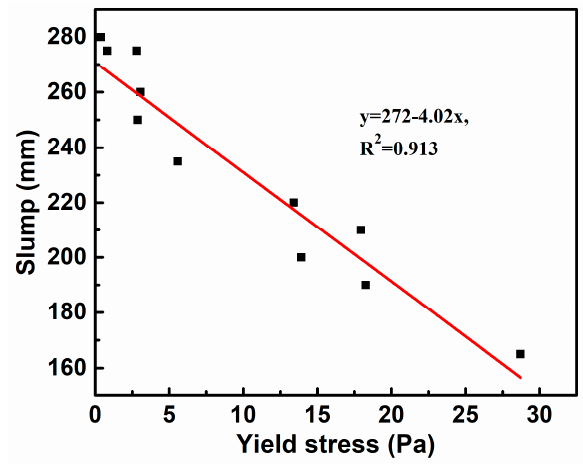
Figure 5. Relationship between fluidity and yield stress of paste.